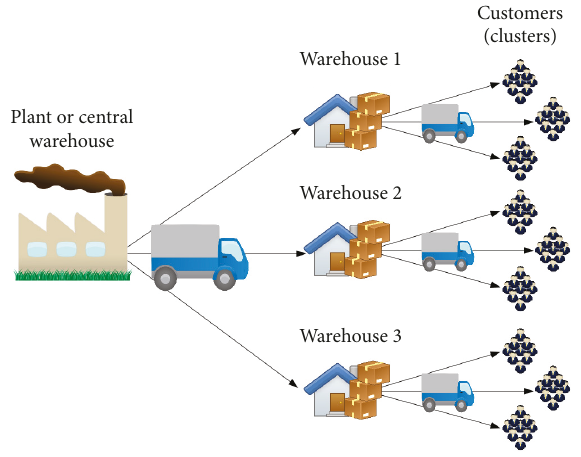
Figure 2: Distribution network structure considered in this